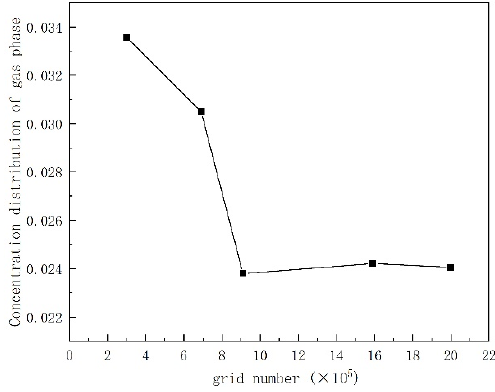
Figure 8. Grid independence verification curve.